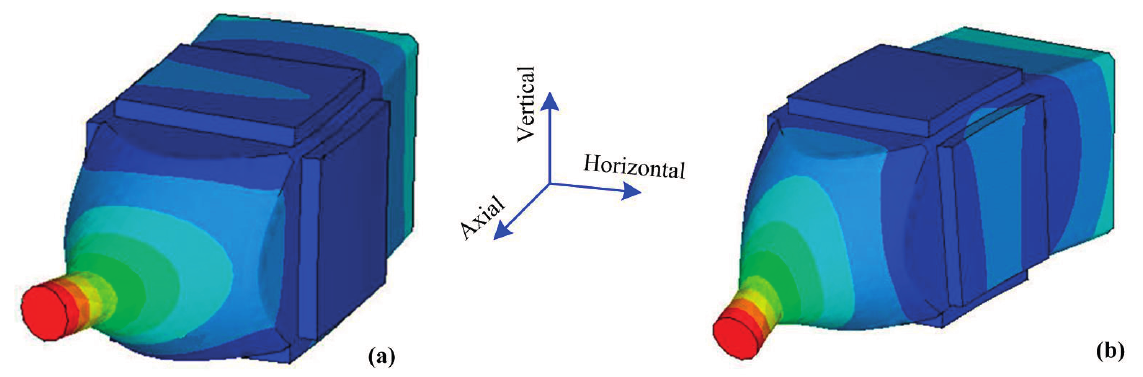
Figure 2. Two first bending vibrations of the transducer: ( a ) horizontal mode; ( b ) vertical